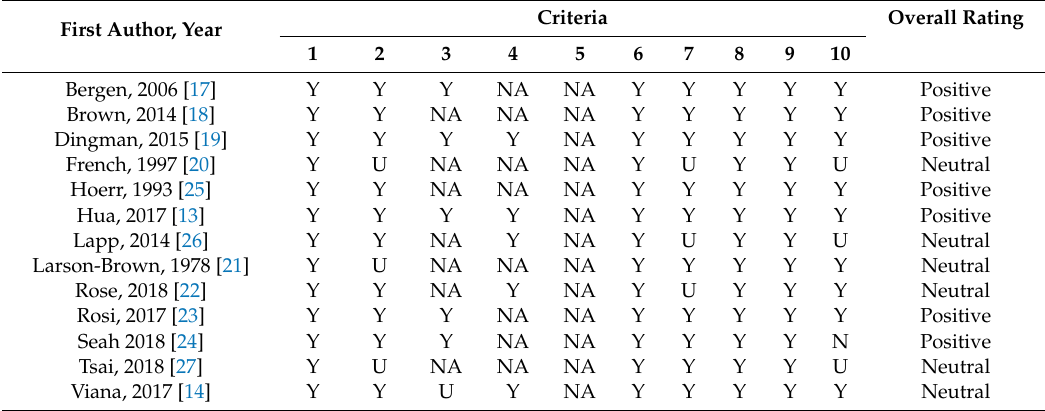
Table 3. Nutrition interventions in vending machines in the university setting: Risk of bias of included